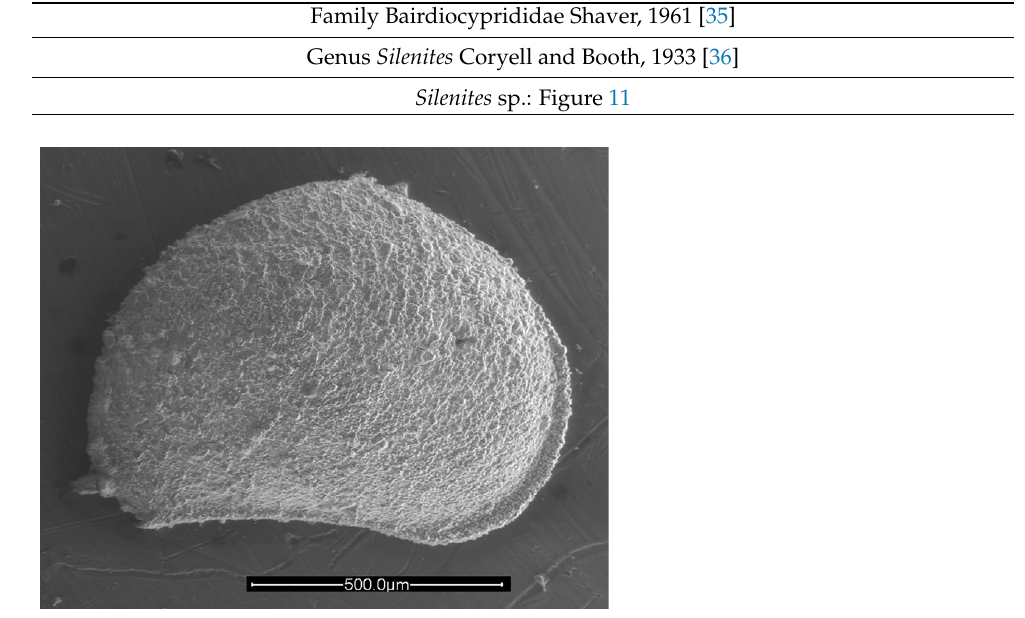
Figure 11. Silenites sp., left valve, lateral view. IGM 5011(7). Scanning electron micrograph (second- ary electrons). Scale bar = 500 microns. electrons). Scale bar = 500